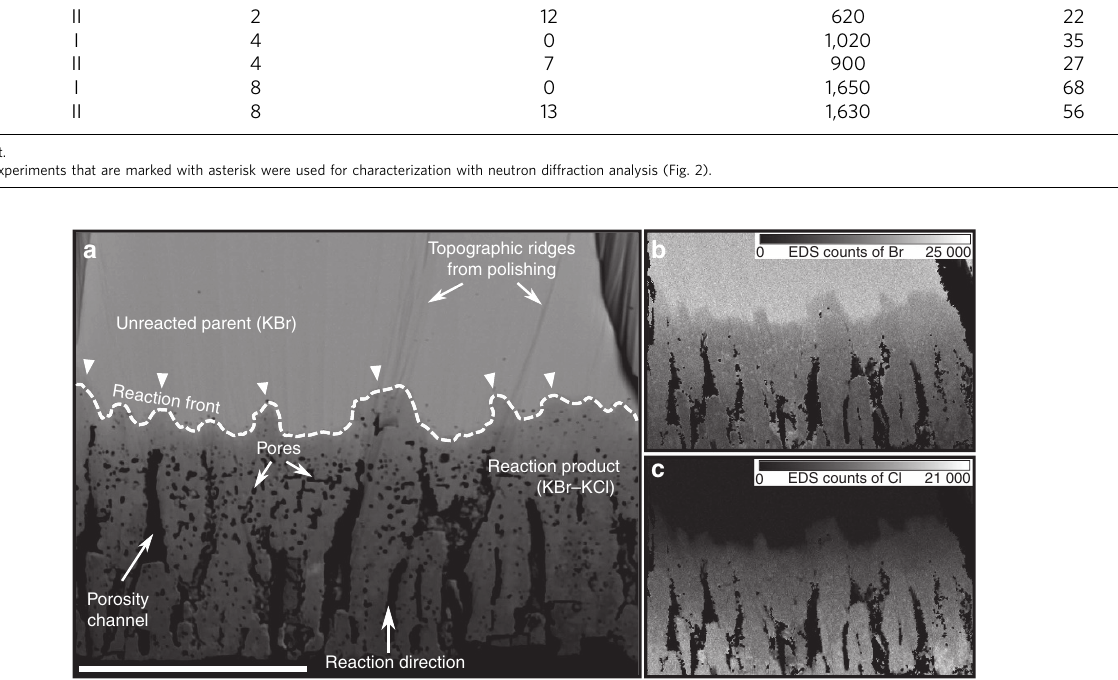
Figure 1 | General characteristics of a sample crosscut after experiment. Scale bar, 500 m m. ( a ) Backscatter electron (BSE) micrograph; note the irregularity of the reaction front (white triangles mark highly advanced parts). Some topographic ridges produced by the polishing method can be seen on the image. They are not visible in chemical ( b , c ) or crystallographic (c.f., Fig. 3a) maps. ( b , c ) EDS counts of Br and Cl in ( a